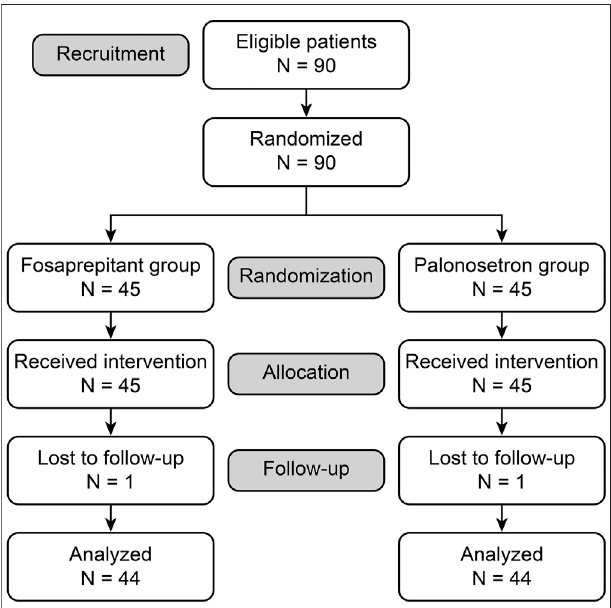
FIGURE 1 | Consort fl